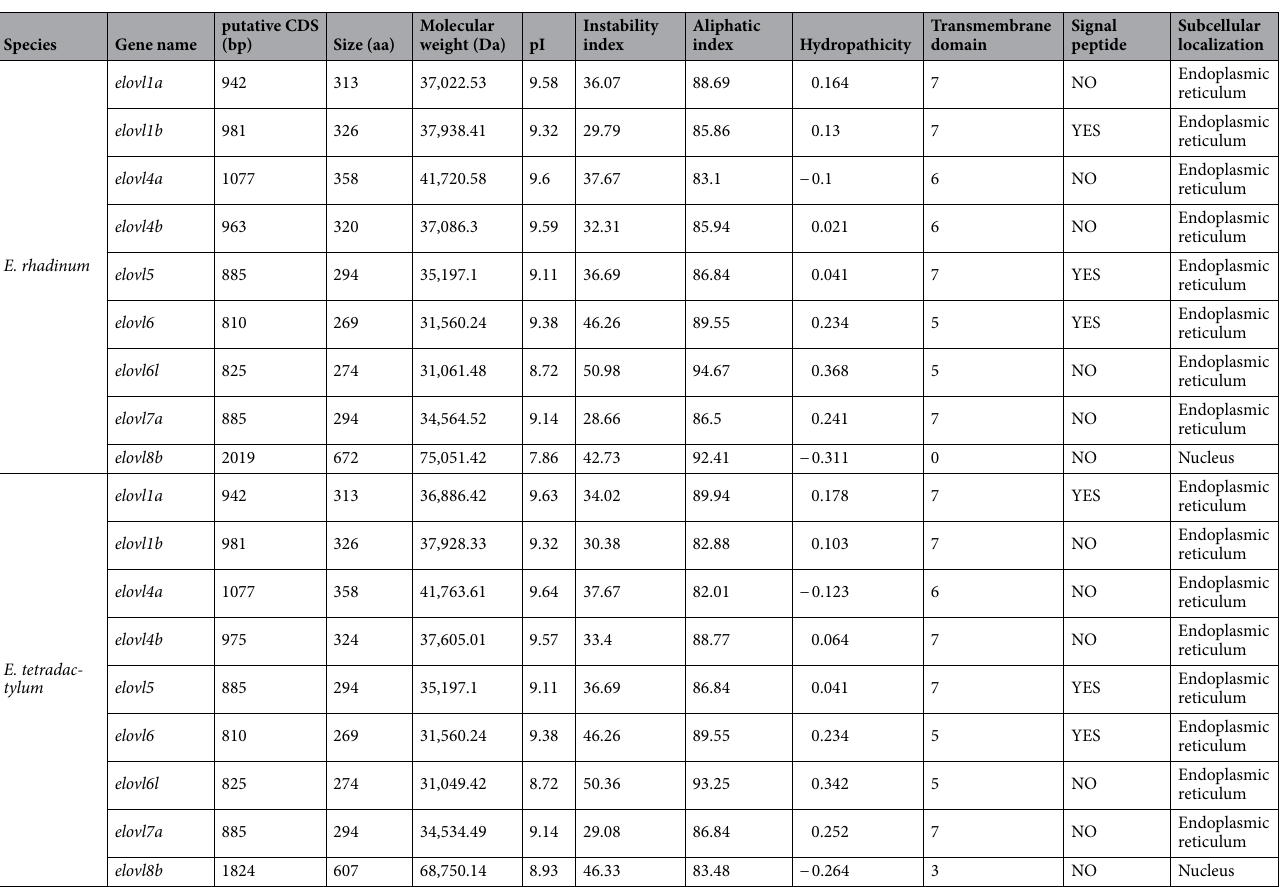
Table 2. Basic information for the Elovl gene family